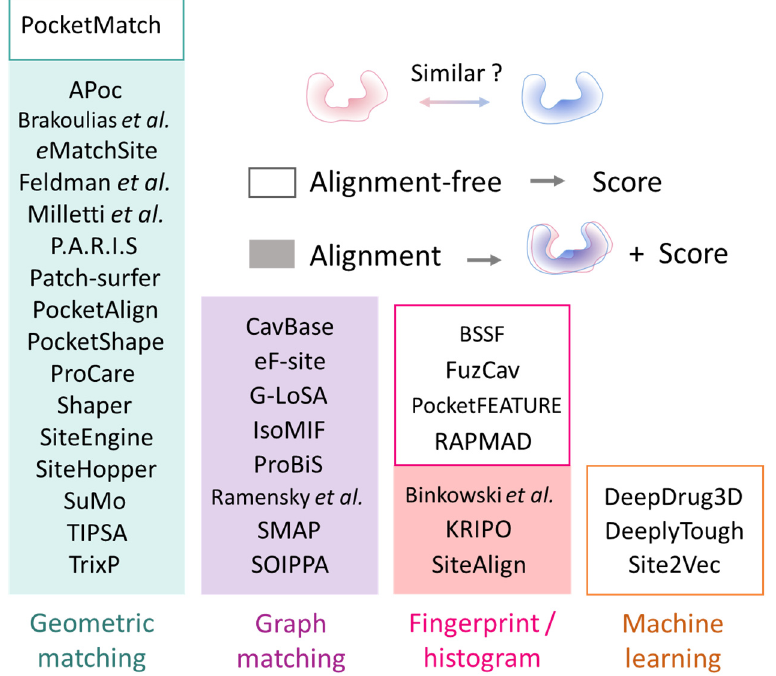
Figure 4. Classification of state-of-the-art methods for protein pockets comparison. Alignment-based methods compute a transformation (rotation, translation) to superpose the query to the target site.